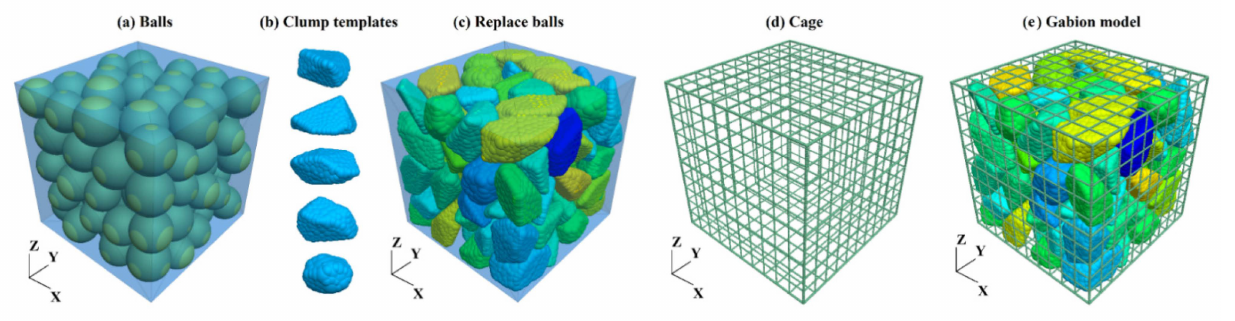
Figure 8. Modeling process of the gabion.